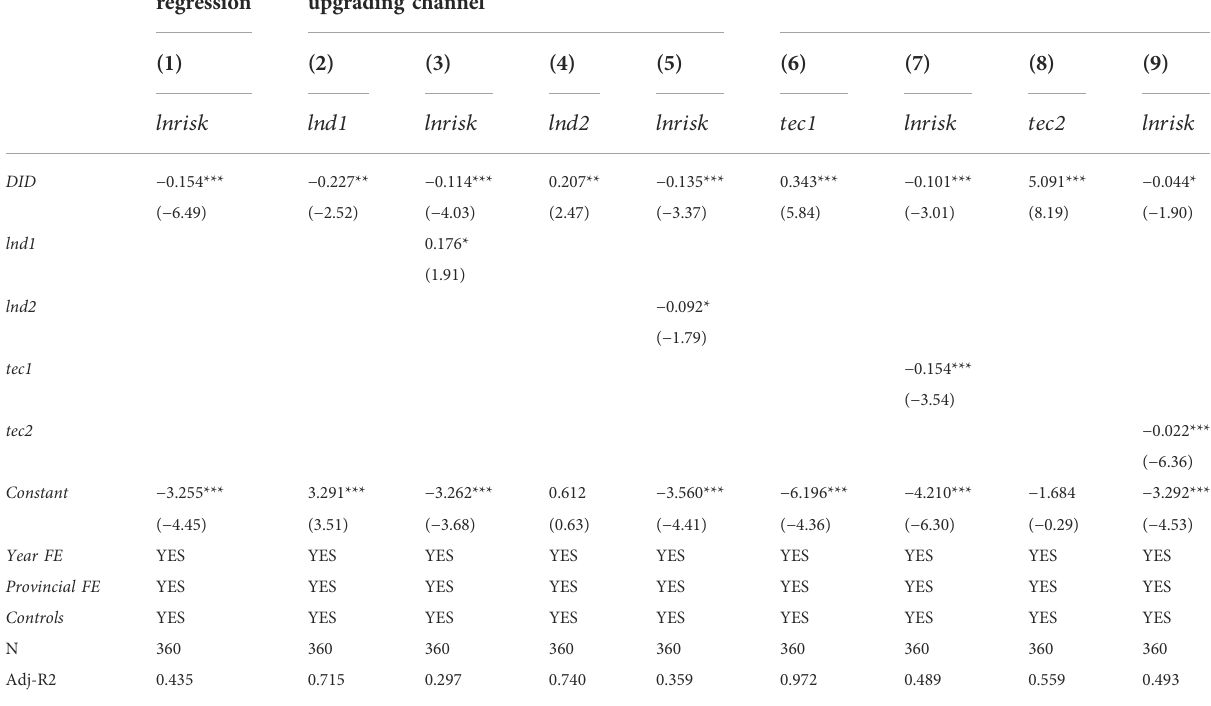
TABLE 6 Action channel test.